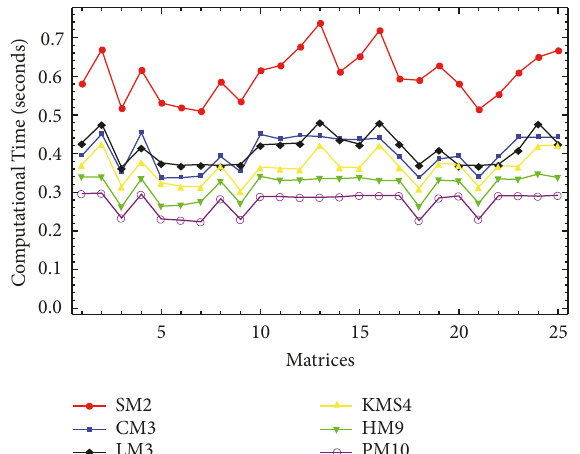
Figure 2: Comparison of the elapsed times for various methods in Experiment 3.